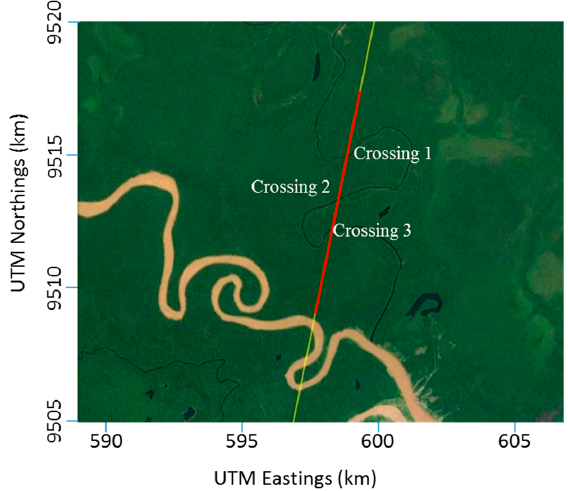
Figure 9. Rio Nahuapa and Envisat Nominal track (IE coverage highlighted in red).